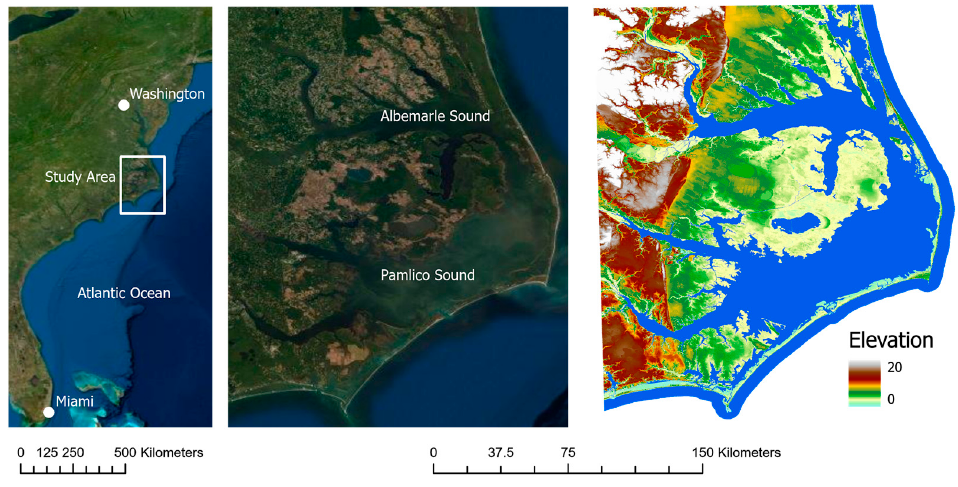
Figure 1. The North Carolina coastal plain is shown both in true color and a LiDAR digital elevation model (referenced to the North American Vertical Datum of 1988).